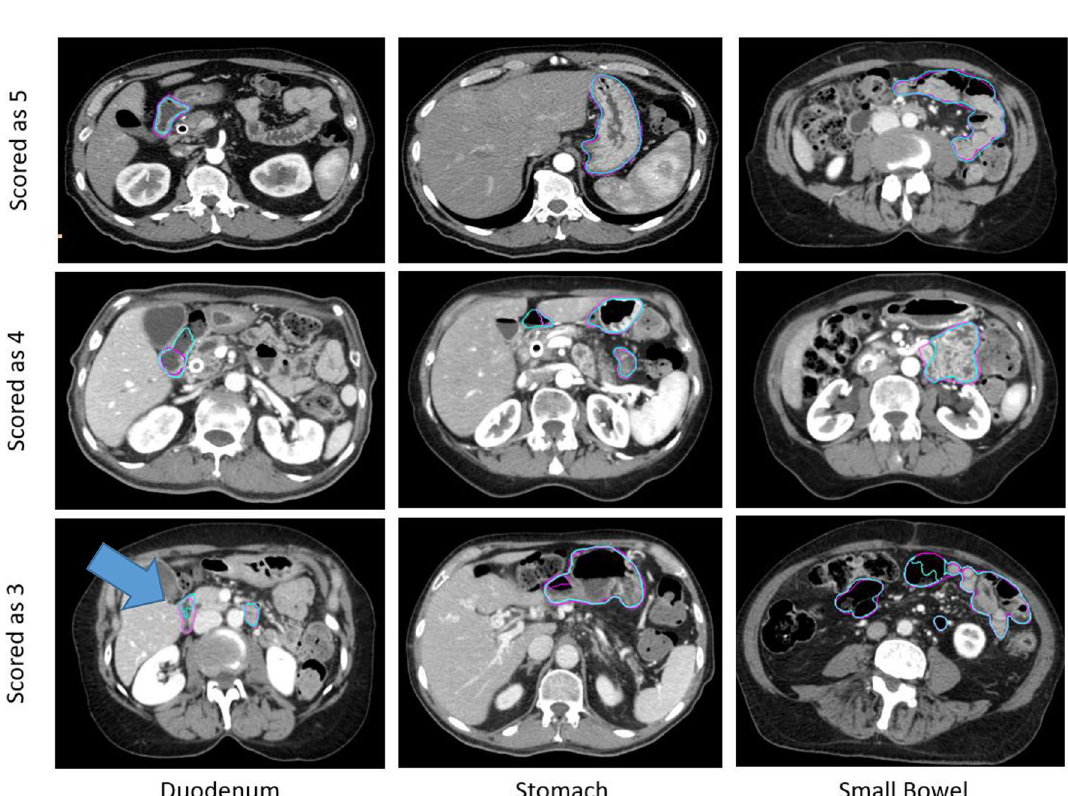
Figure 4. Representative contours of organs scored on a Likert scale as 5, 4, and 3 (top to bottom) by physicians. The ground truth contours are shown as purple in all images. The automatically generated contours are shown as cyan in all images. The arrow indicated a segment of under-contoured duodenum that required minor